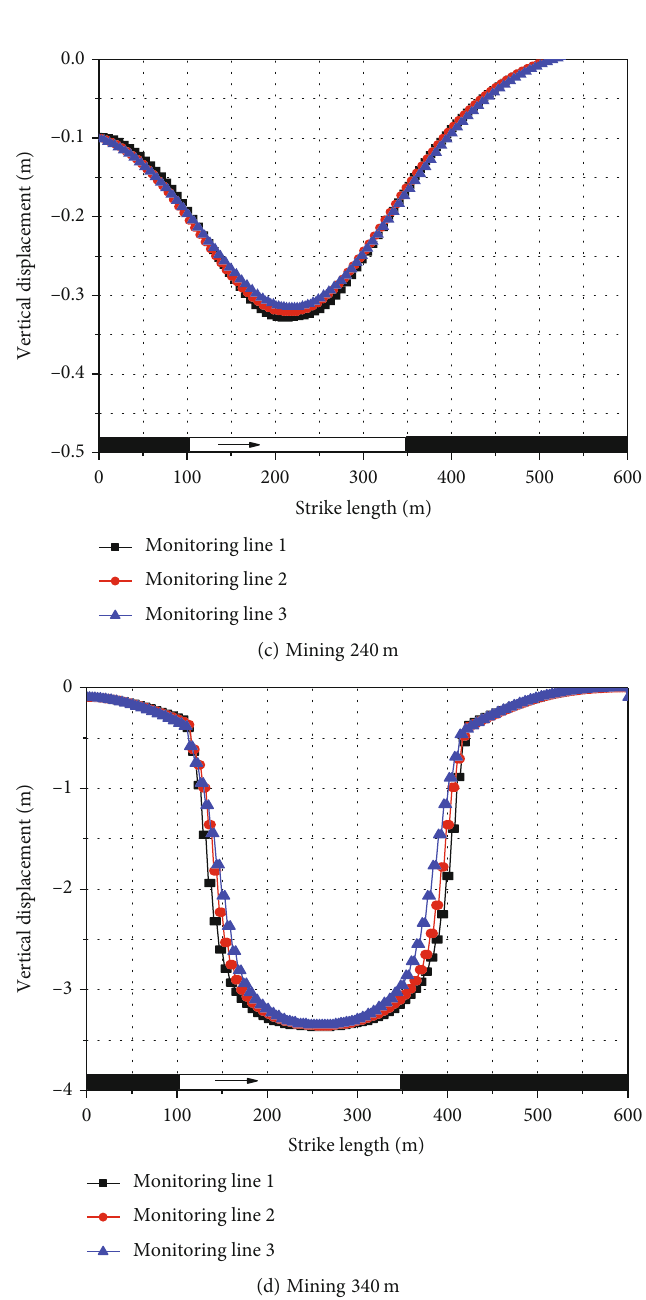
Figure 11: The subsidence curve at di ff erent positions of THR during the mining